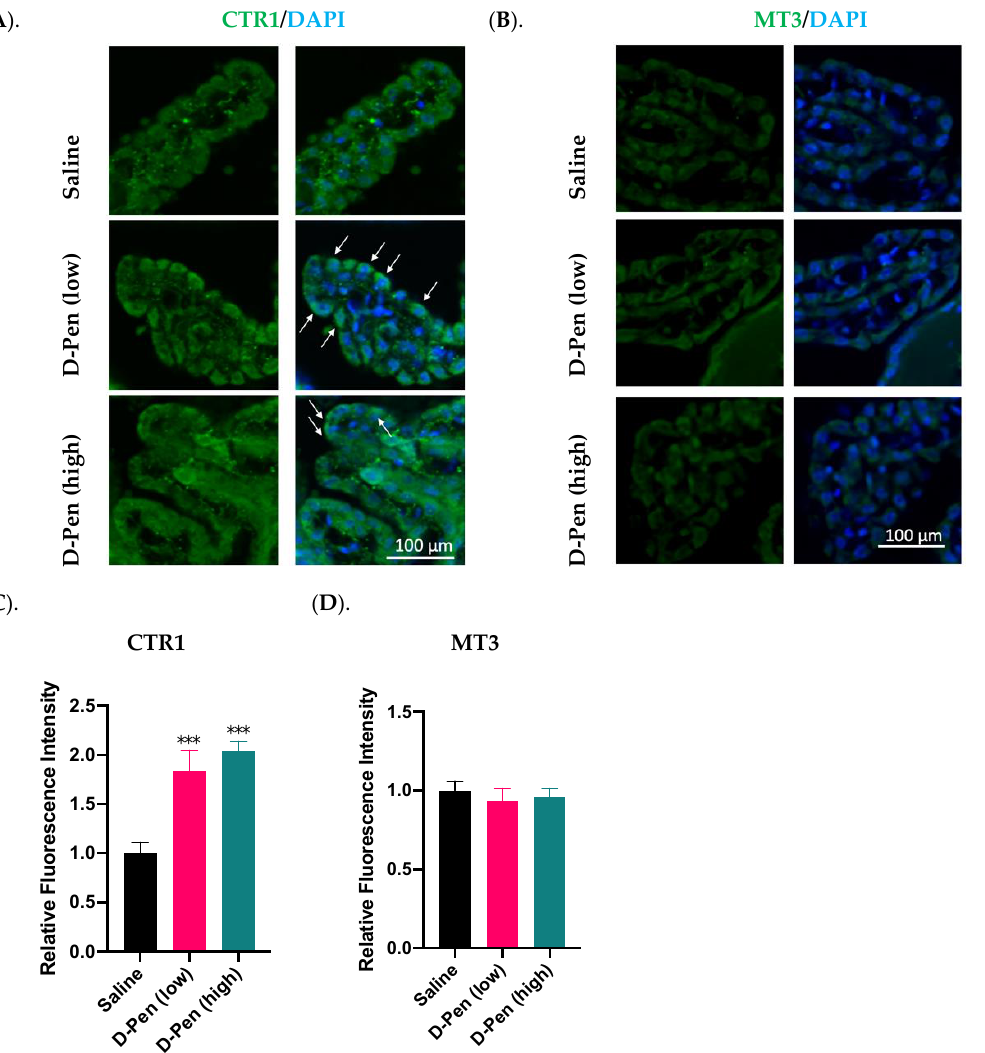
Figure 12. Expression of Cu regulatory proteins in the choroid plexus following long-term ICV infusion of D-Pen. ( A ). Expression of CTR1 in the choroid plexus. White arrows indicate CTR1 translocation toward the apical aspect facing the CSF. Scale bar = 100 µ m. ( B ). Expression of MT3 in the choroid plexus. Scale bar = 100 µm. ( C ). Quantification of average CTR1 immunofluorescent intensity in choroid plexus using multiple slices per brain. ( D ). Quantification of average MT3 immunofluorescent intensity in choroid plexus using multiple slices per brain. For panels ( C , D ), data represent mean ± SD, n = 3/group. *** p < 0.001, as compared with the controls.